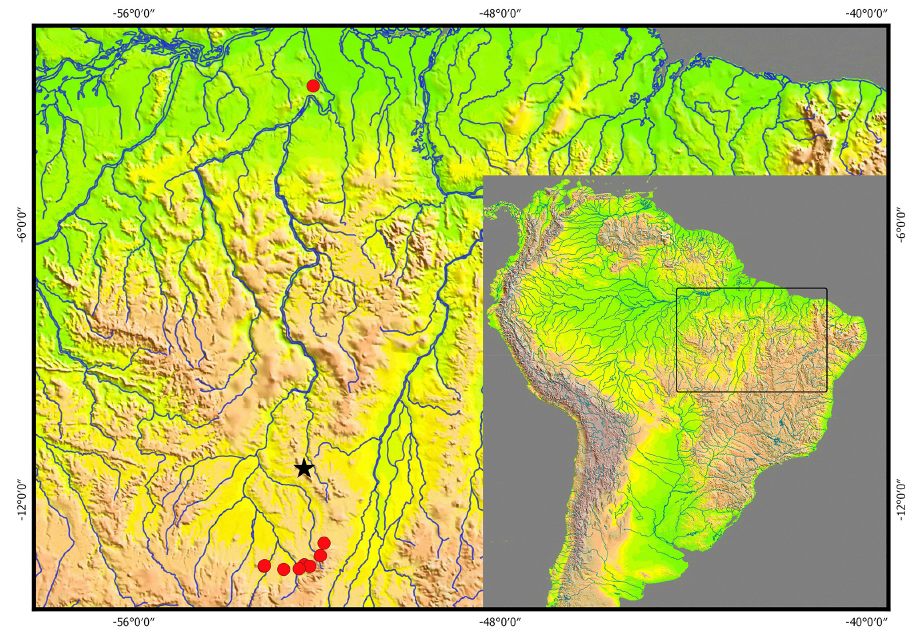
FIGURE 7 | Geographic distribution of Phenacorhamdia suia in Brazilian Shield. Black star = holotype. Red circles = paratypes